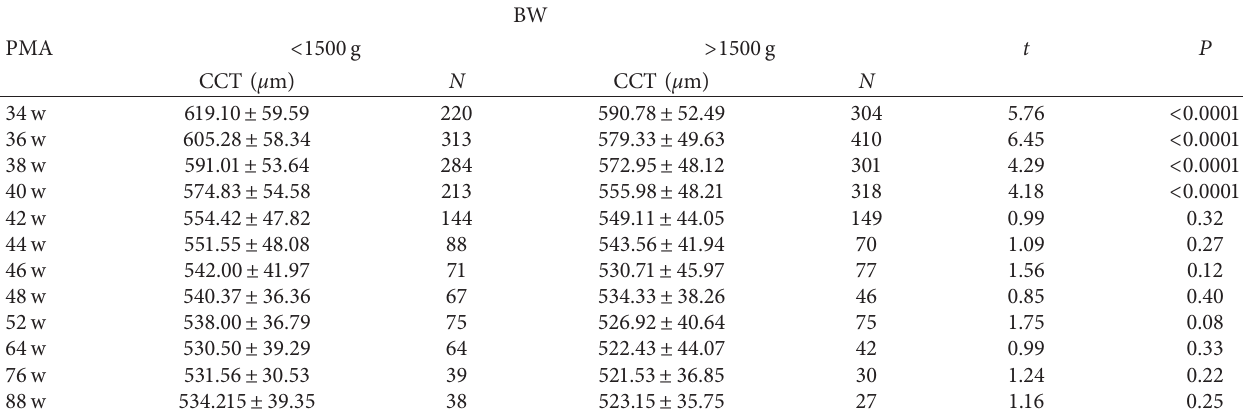
Table 4: Mean CCT of different BWs at each PMA.